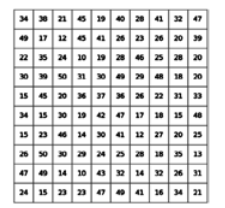
Figure 1. A random test data set on a 10x10 grid.